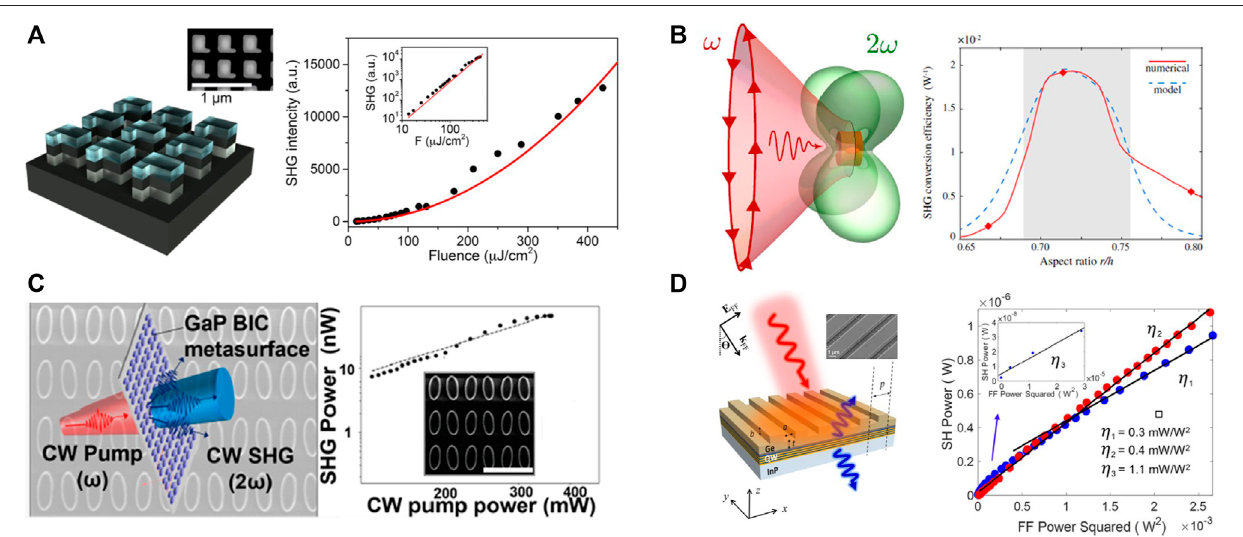
FIGURE6| EnhancementofnonlinearSHGprocessfromresonantdielectricnanostructures. (A) SymmetrybrokenGaAsmetasurfaceusedtocreatehigh-QFano resonances and power dependence of the SH intensity plotted against the pump fl uence (Vabishchevich et al., 2018). (B) SHG from a subwavelength dielectric nanoparticle pumped by an azimuthally polarized beam at the BIC conditions and the conversion ef fi ciency as a function of the nanoparticle aspect ratio (Carletti et al., 2018a). (C) Illustration of the continuous wave SHG enabled by quasi-BIC on GaP metasurface, and the SHG power as a function of input CW pump power for angles of the dimer 5 ° (Anthur et al., 2020). (D) Illustration of the dielectric-semiconductor nonlinear device and SH power as a function of the square of incident pump power for the structures with different low incident powers (Sarma et al., 2019).